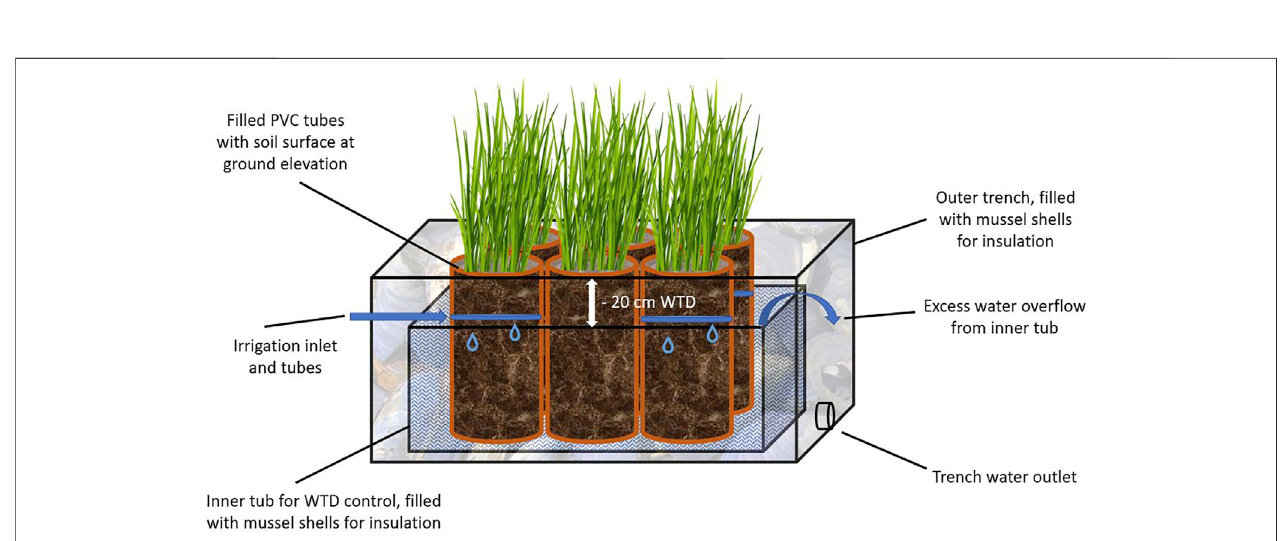
FIGURE2| Schematicsketchoftheexperimentalsetuprepresenting watertabledepth(WTD)controlofthepolyvinylcarbonate(PVC)cylinders, fi lledwithsoiland cultivated with the various grass species.